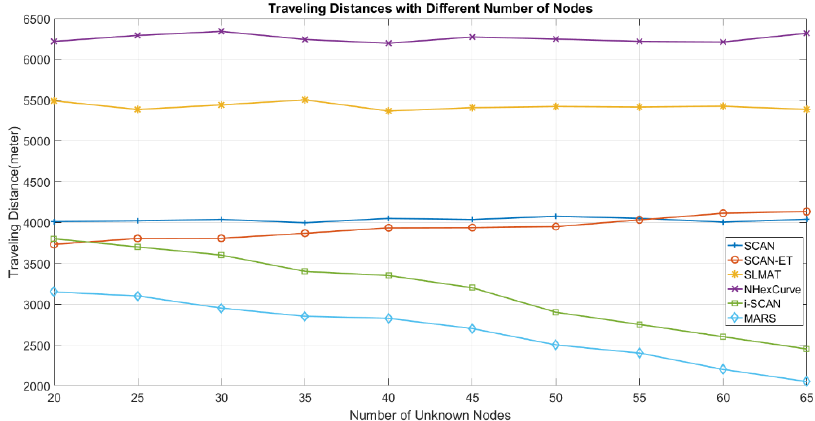
Figure 5. Traveling distances with different numbers of unknown nodes (R = 100 m).